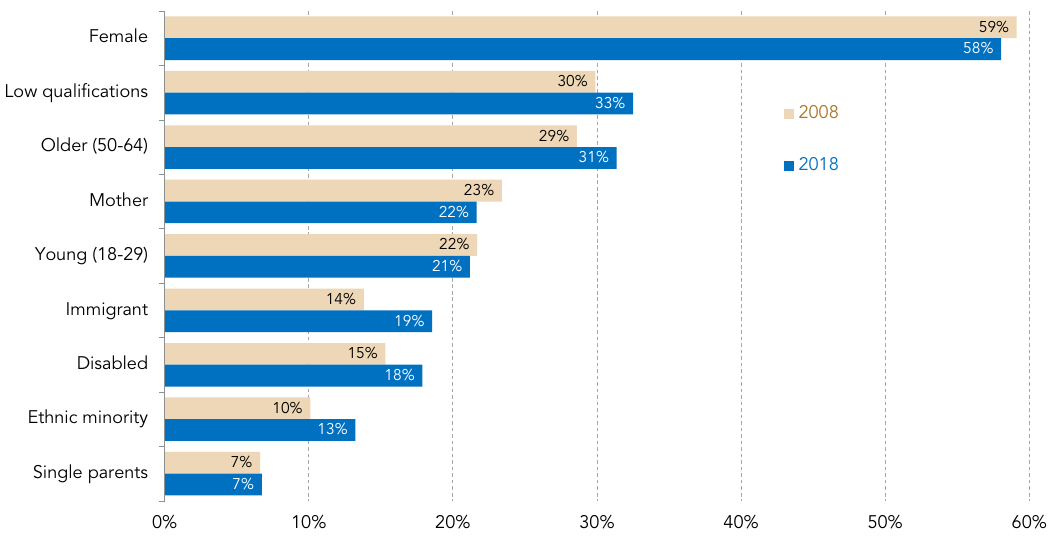
Figure 34: The composition of the atypical worker group has become somewhat more